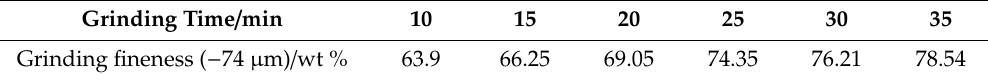
Table 7. Relationship between grinding fineness and grinding time of the roasted product / wt %. Grinding Time /